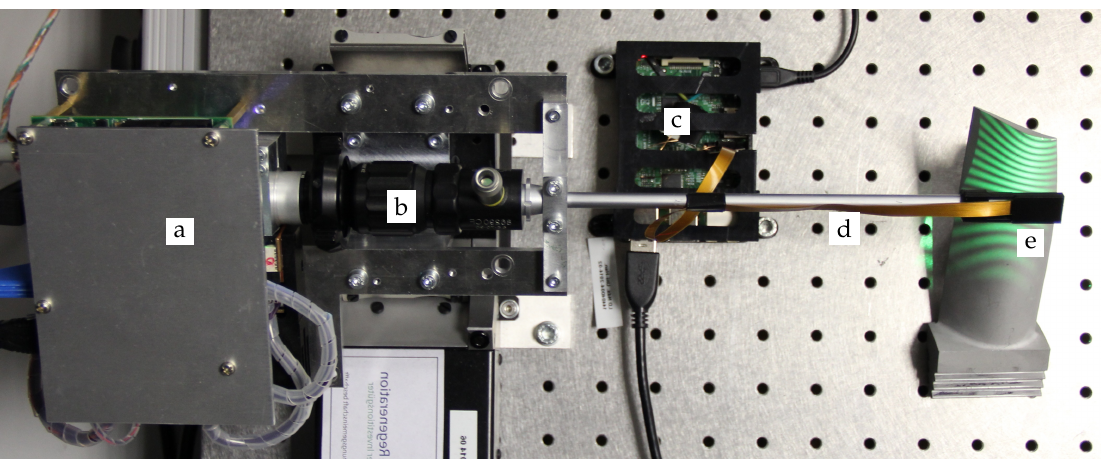
Figure 3. Photograph of the measurement system from the top. The labels are consistent with Figure